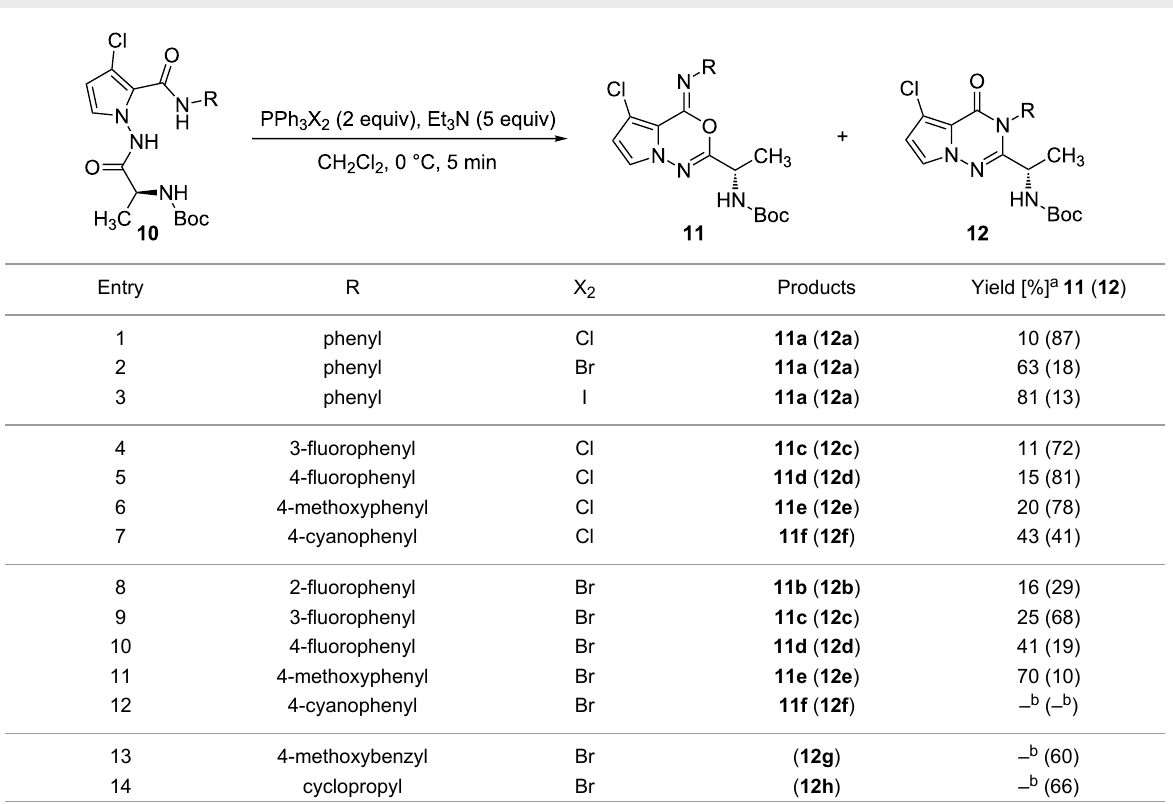
Table 3: Investigation of